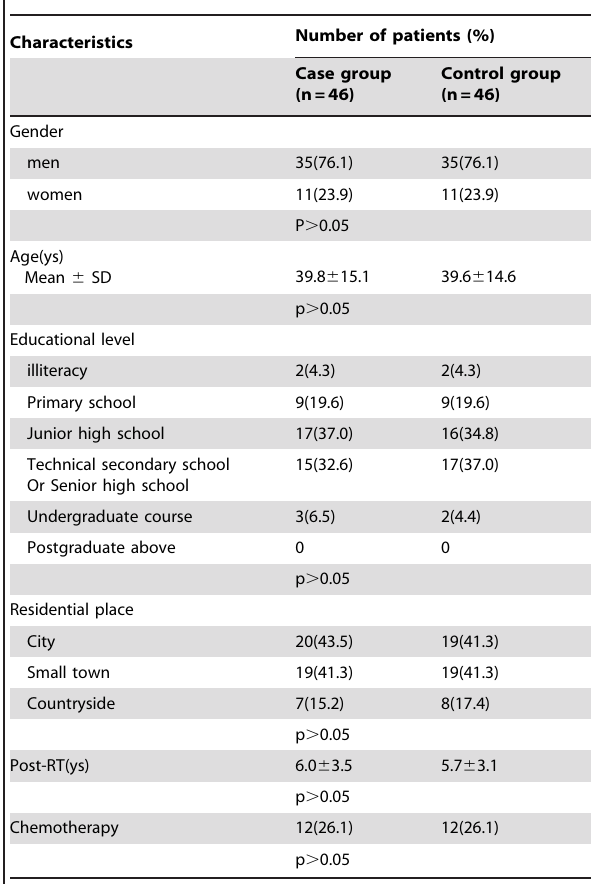
Table 1. Characteristics of the two